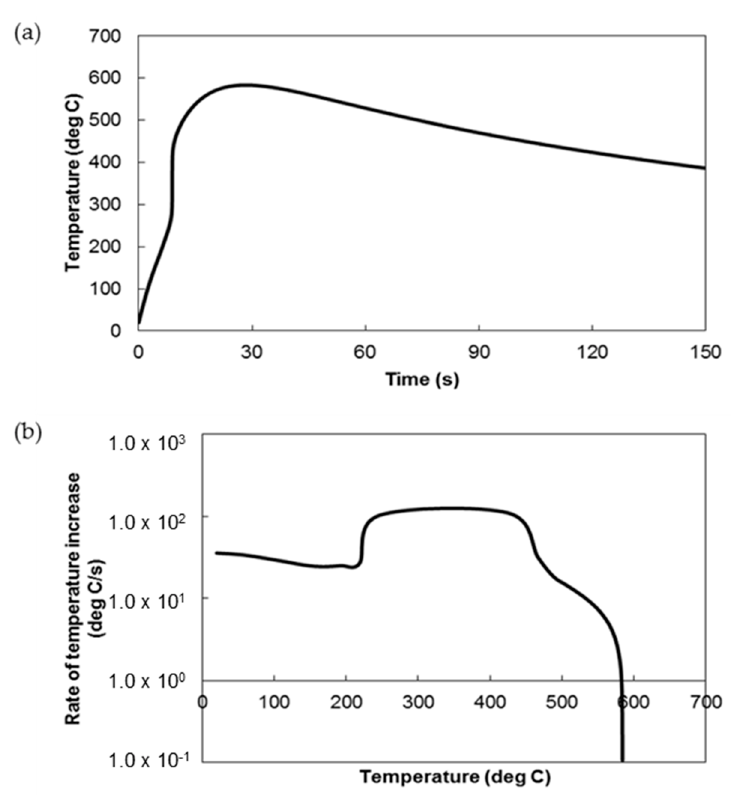
Figure 3. ( a ) Thermal runaway profile of a short-circuited battery; ( b ) rate of temperature increase profile during short-circuit.